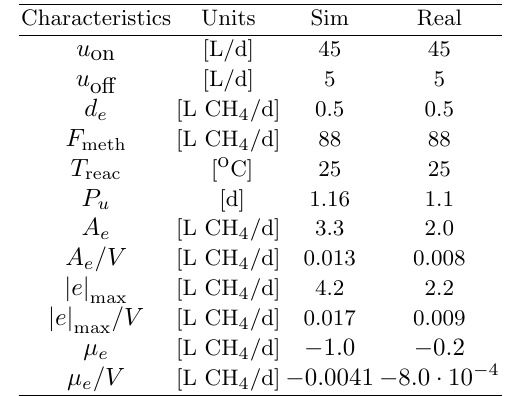
Table 1: Settings and steady-state characteristics for simulated and practical experiments with on- off